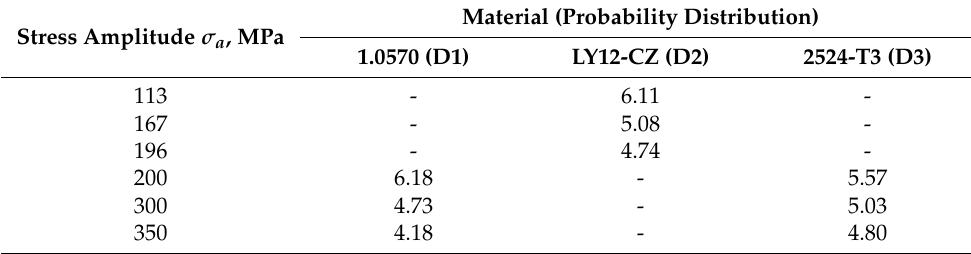
Material (Probability Distribution)